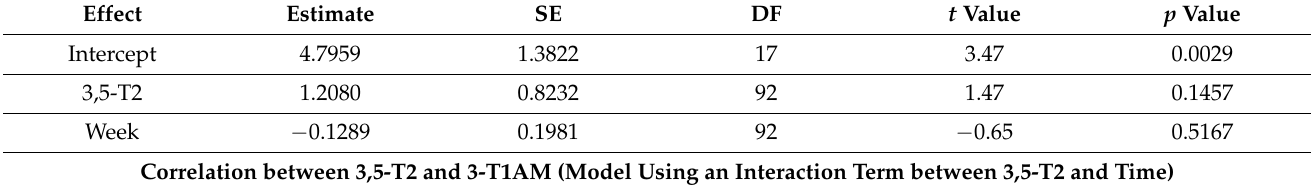
Table 4. Correlations between 3,5-T2 and 3-T1AM concentrations during the weekly sampling in the patients with hypothyroidism. (* = interaction term).